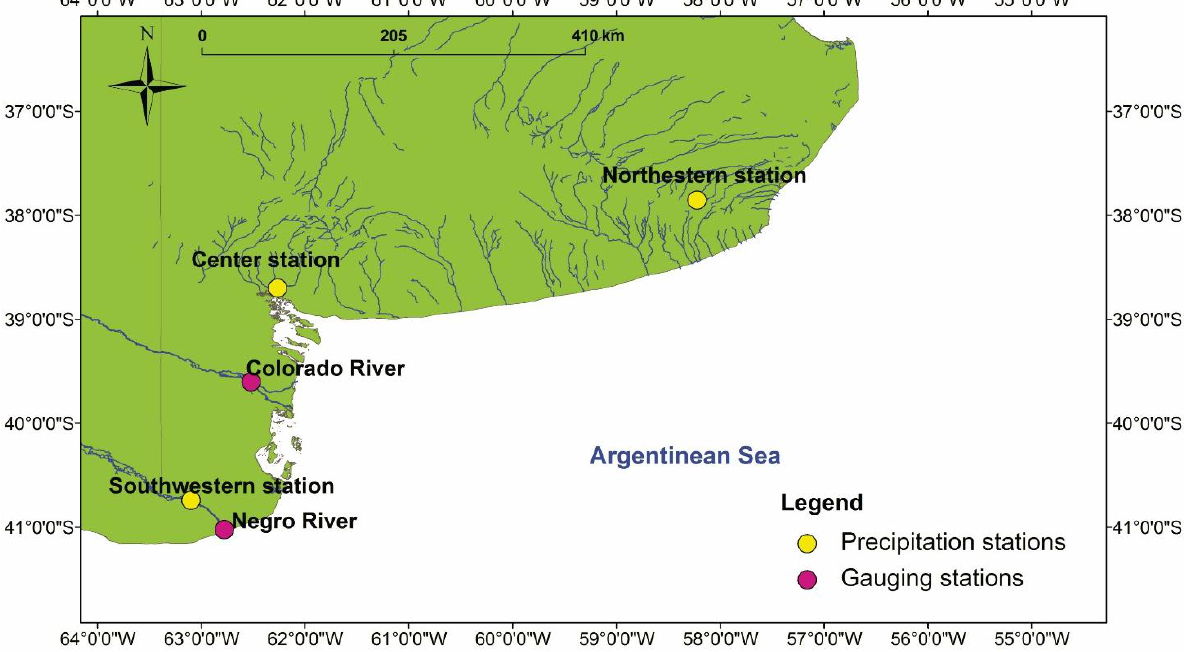
Figure 2. Location of the in situ stations of precipitation and river discharges in the study